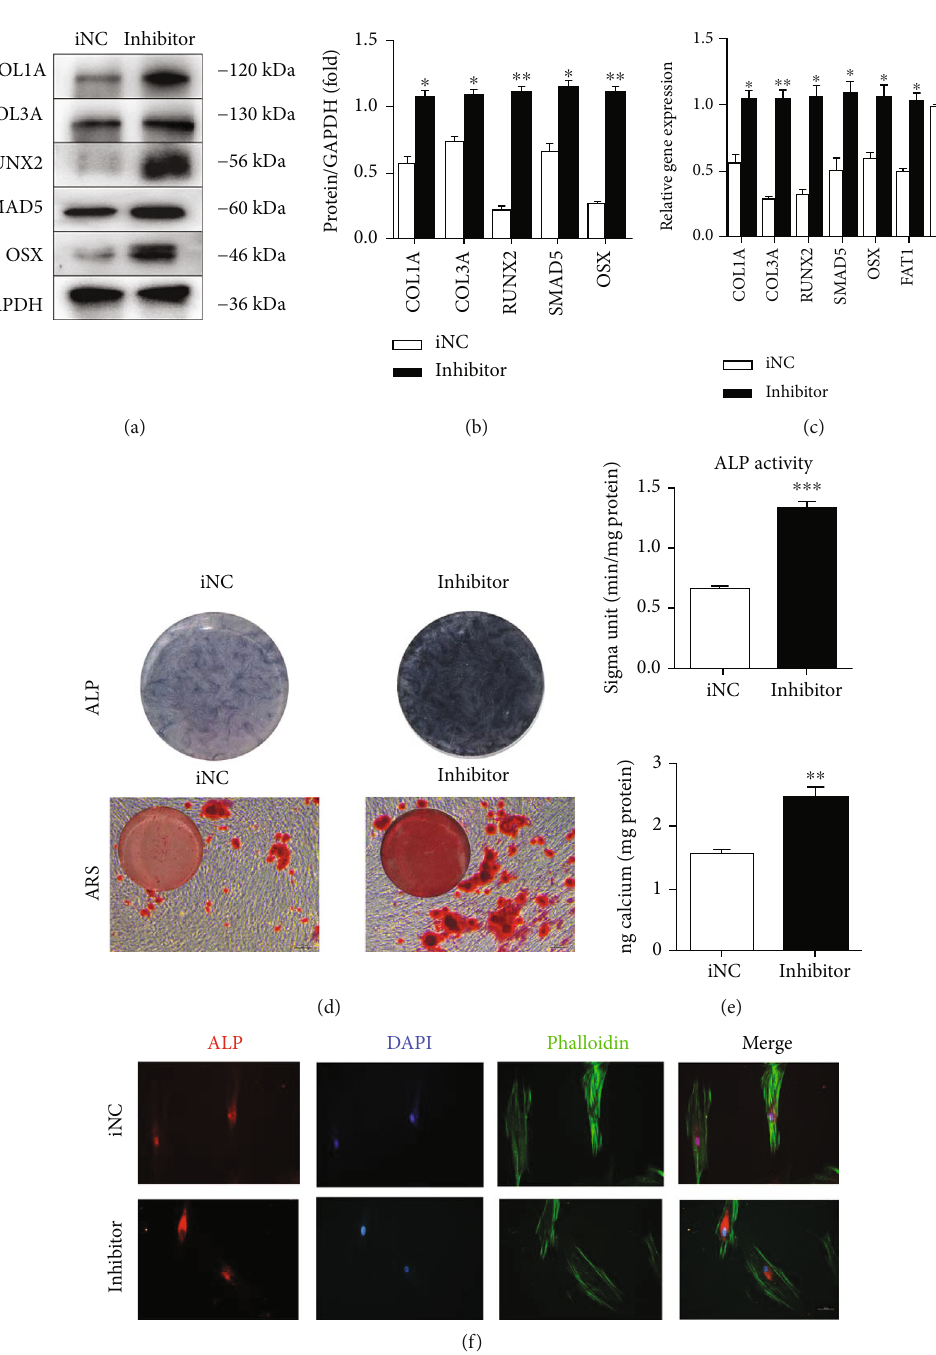
Figure 6: Knockdown of miR-4781-3p increases osteoblastic di ff erentiation tendency of PDLSCs. (a) – (c) The results of Western blot and RT-qPCR showed SMAD5 and osteogenic markers (RUNX2, OSX, COL1A, and COL3A) were upregulated in the miR-4781-3p inhibitor transfected PDLSCs (inhibitor group). In addition, RT-qPCR results showed that the expression of circFAT1 was upregulated, and miR- 4781-3p was downregulated in the inhibitor group. (d, e) Knockdown of miR-4781-3p increased the ALP activity of PDLSCs 7 days after osteogenic induction. ARS showed the mineralization of PDLSCs was added signi fi cantly in the inhibitor group after osteogenic induction for 14 days. (f) Immuno fl uorescence experiments con fi rmed the increased expression of ALP in the inhibitor group. ∗ P < 0 : 05 , ∗∗ P < 0 : 01 , and ∗∗∗ P < 0 : 001